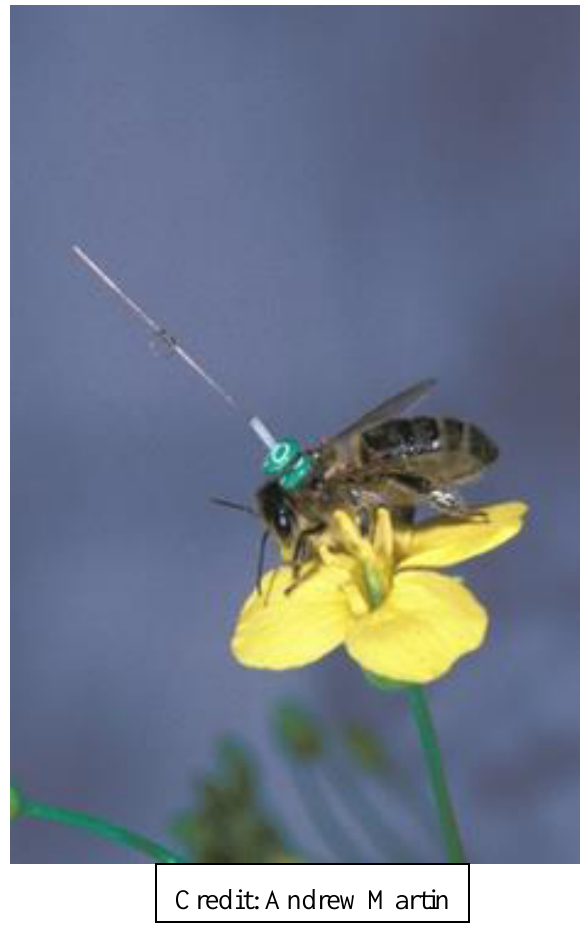
Credit: Andrew Figure 4. Harmonic radar marking and tracking chip. Note the tall, vertical antennae.